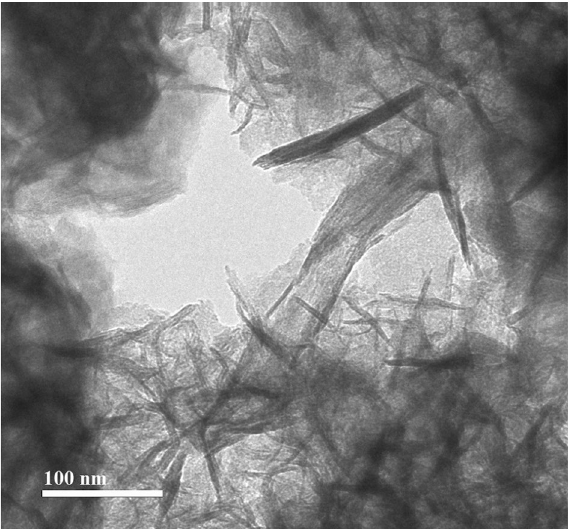
Figure 2. HR-TEM image of the green-synthesized nickel-ferrite nanowhiskers.